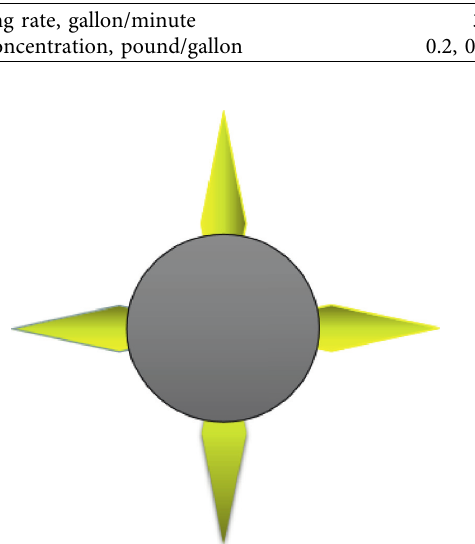
Figure 2: Perforation displaced in the pipe at 90 degrees for each cluster.